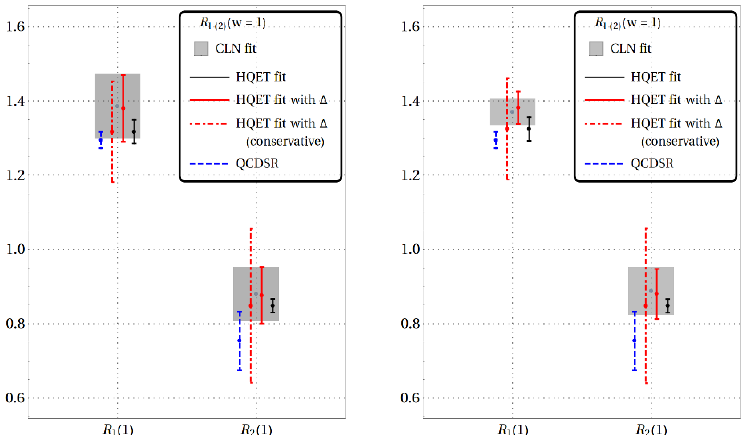
Figure 1 . Comparisions between di(cid:11)erent R 1 (1) and R 2 (1) which are obtained from di(cid:11)erent (cid:12)ts, with (right) and without (left) the inputs from LCSR, and QCDSR. For the conservative estimates of R ( w = 1), (cid:1) v is taken as 1 (cid:6) 0 : 1 and each of (cid:1) 21 and (cid:1) 31 is considered as 1 (cid:6) 0 : 2. 1(2) reproduce the CLN (cid:12)t results, as well as the QCDSR predictions; the results are shown as dot-dashed red bars in (cid:12)gure 1. Using the results given in table 8, we estimate R